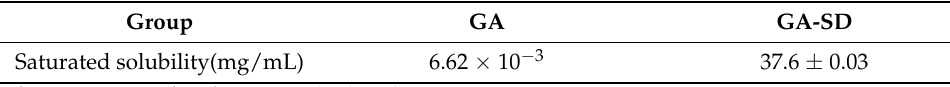
Table 1. Saturated solubility of GA and GA-SD. Group GA GA-SD Saturated solubility(mg/mL)